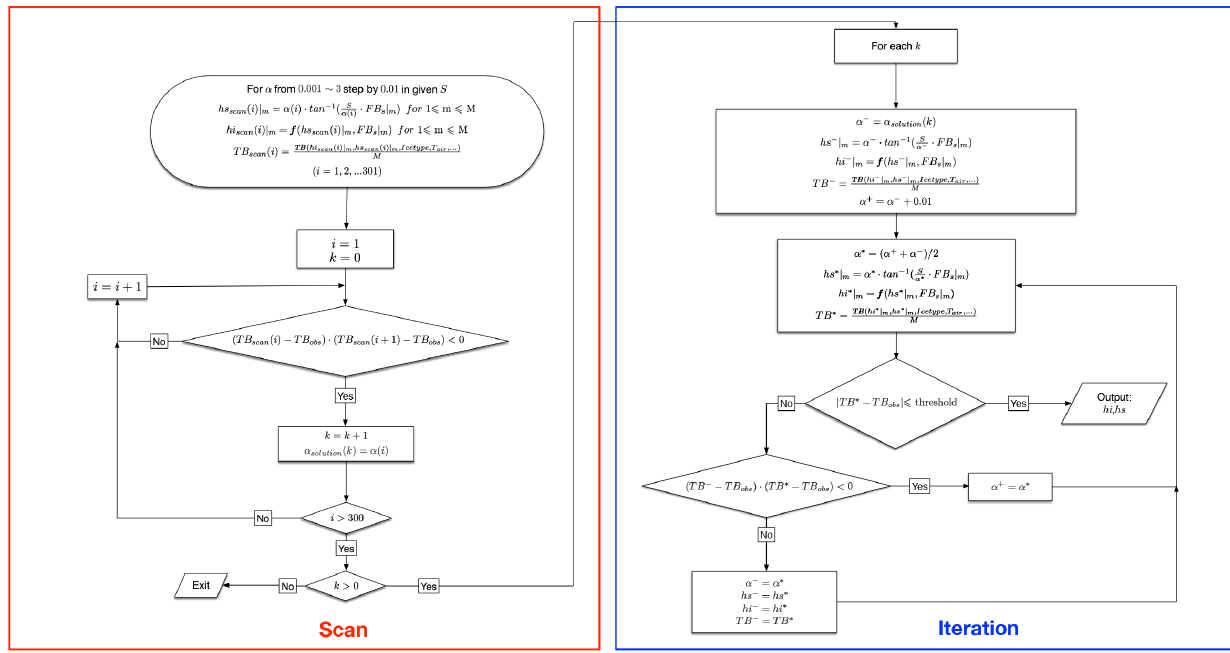
Figure 7. Flow chart for retrieval algorithm. Two phases are marked out. The red box includes the scanning process for the potential solutions to the retrieval problem, and the blue box shows the iterative binary search for the solving